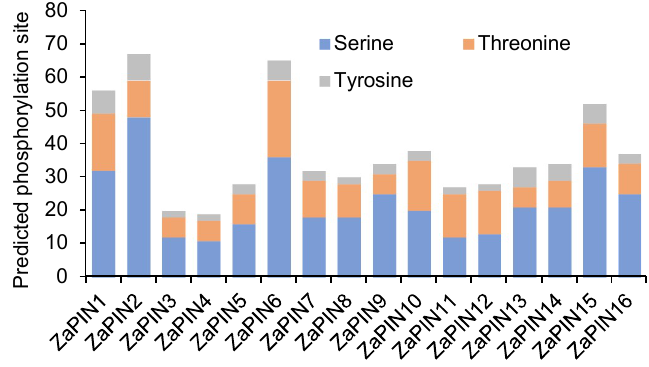
Figure 2. Predicted phosphorylation sites in ZaPINs.